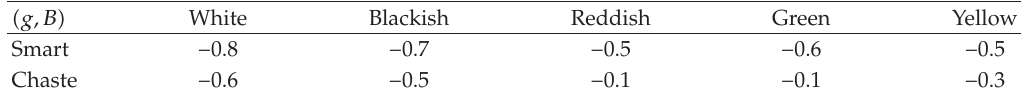
Table 5: Tabular representation of (cid:2) g,B (cid:3)